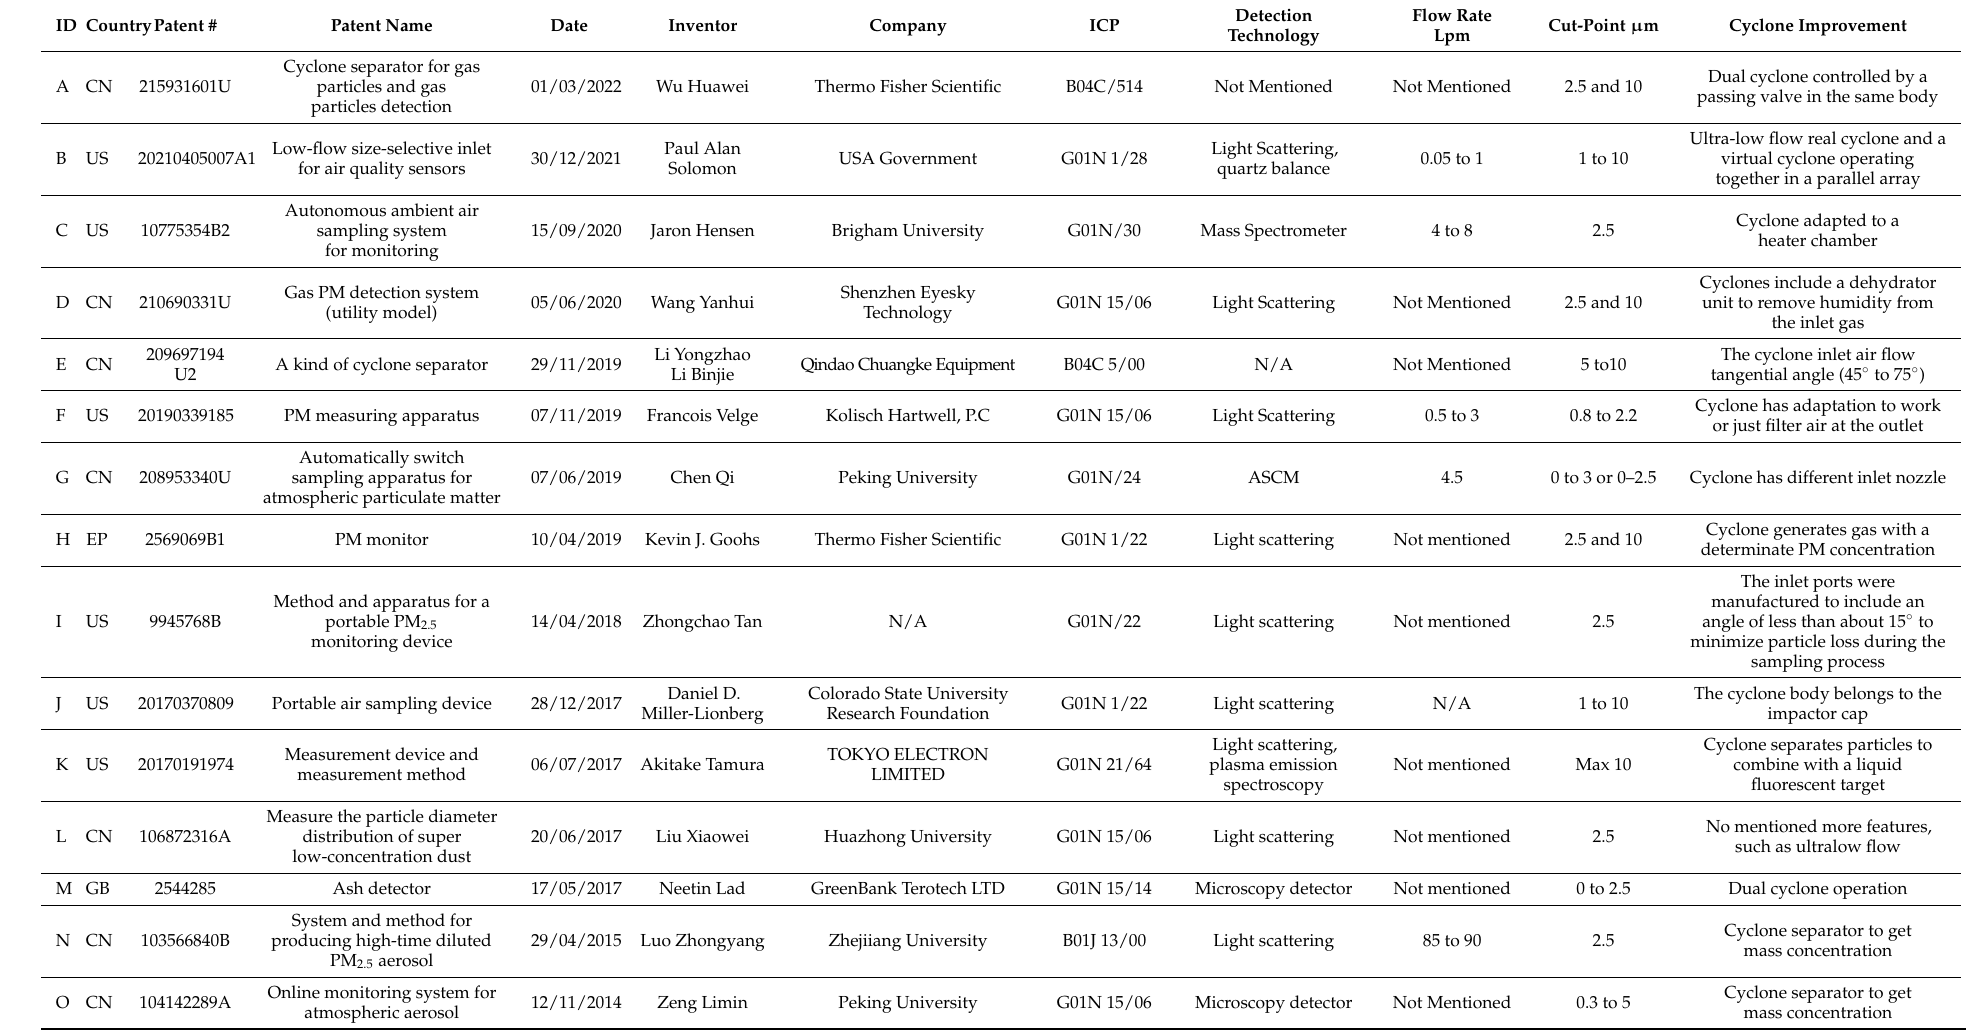
Table 4. List of patents that met the inclusion criteria. Data extracted from patents’ records